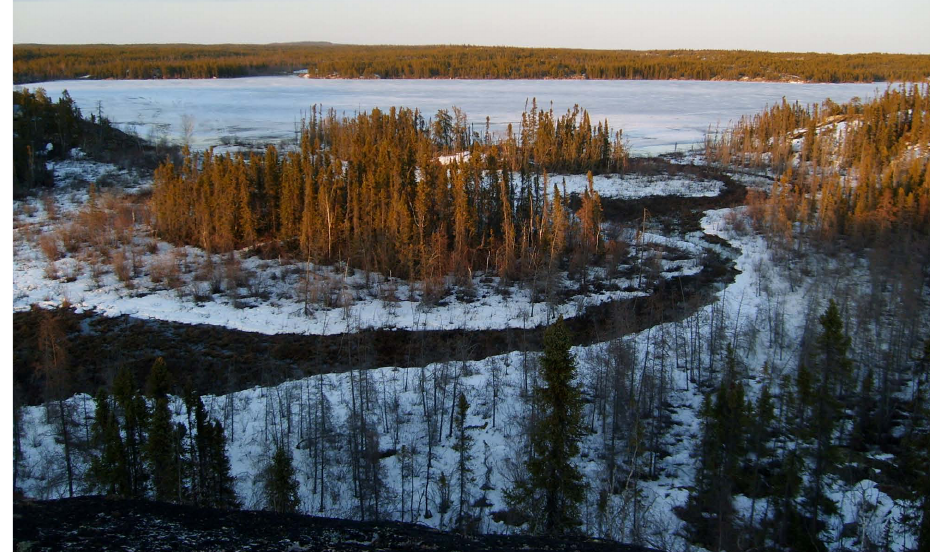
Fig. 4. The wetland site on 6 May 2008 during the snowmelt period. Snow and ice melted at a faster rate along surface runoff routes, while much of the remaining snow covered areas were outside of flow pathways. Photo was taken facing east with Vital Lake (ice covered) in the background.